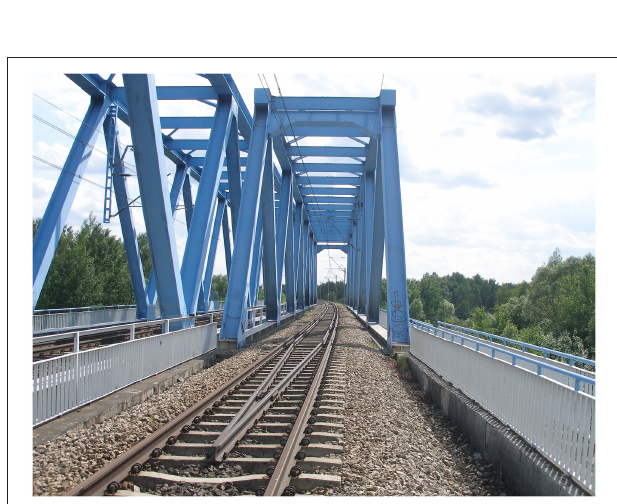
FIGURE 6 | Lateral view of the first presented railway bridge; from Olaszek (2015) permission was granted by The Committee on Civil Engineering and Hydroengineering of the Polish Academy of Sciences.